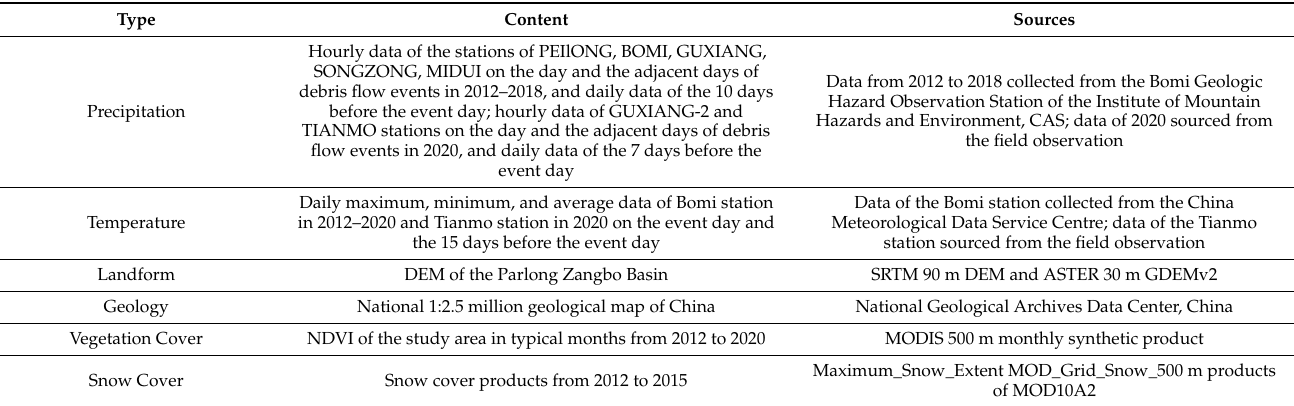
Table 2. Data types and